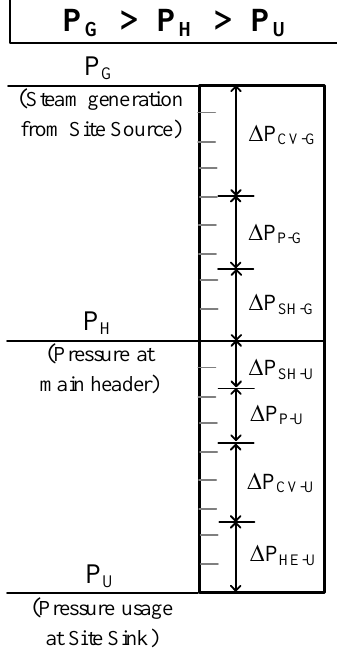
Figure 4. Pressures and pressure drops at a steam distribution